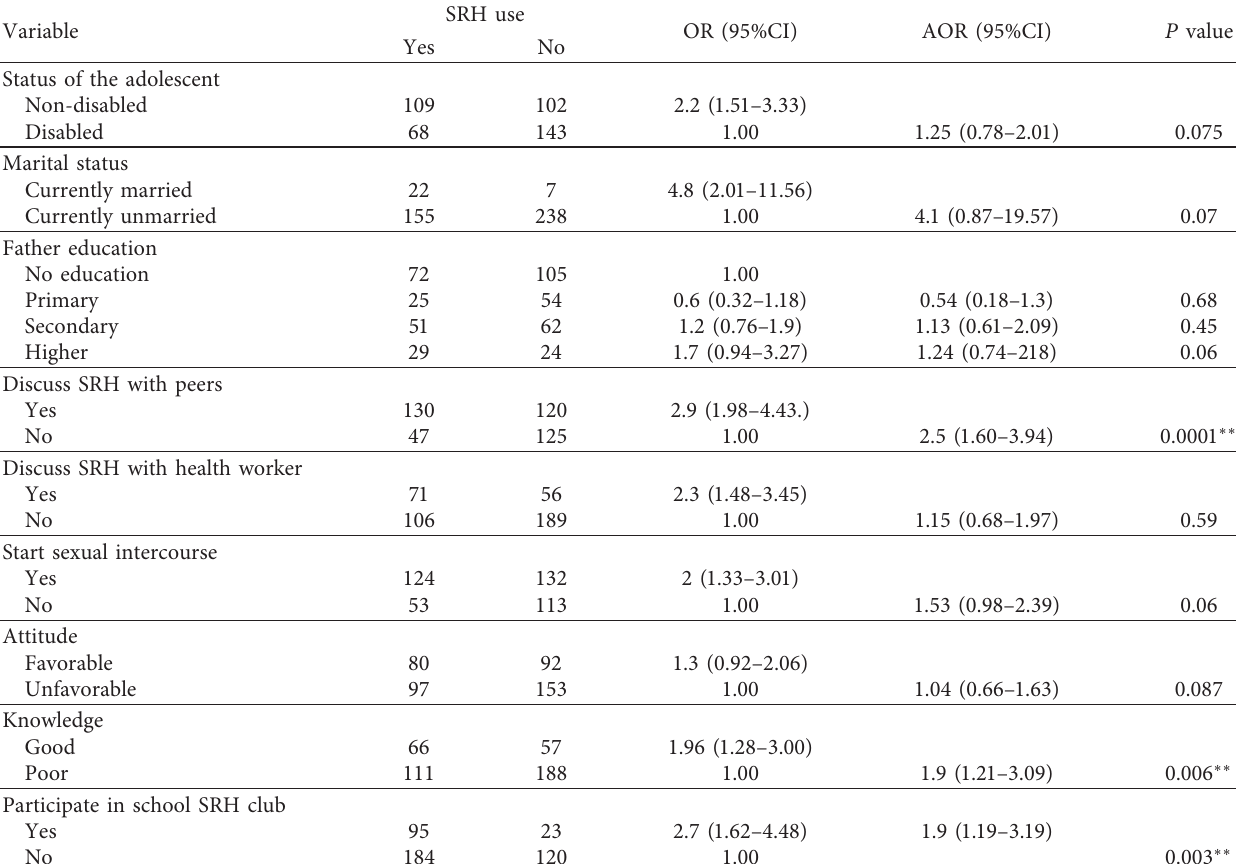
Table 3: Factors associated with sexual and reproductive health service utilization among adolescents in Arba Minch town school,